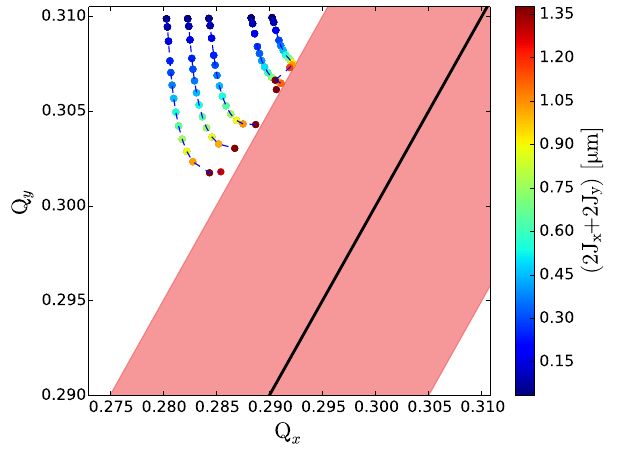
FIG. 4. Tunes from tracking with linear closest tune approach of 0.015 and h 1111 ¼ 0 by powering MOF with opposite polarity than MOD. The vertical kicks range from 0.5 mm to 4.5 mm while the horizontal were kept at 0.5 mm. The light red area delimits the linear coupling stopband of 0.015.